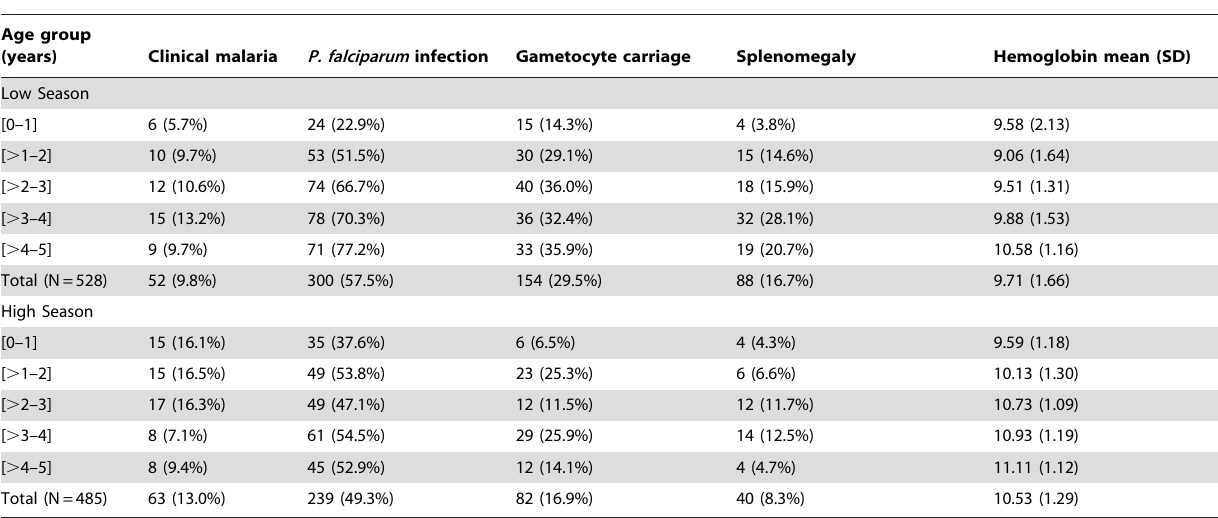
Table 5. Malariometric parameters Prevalence by Age Group in active surveillance cohort according to the season.